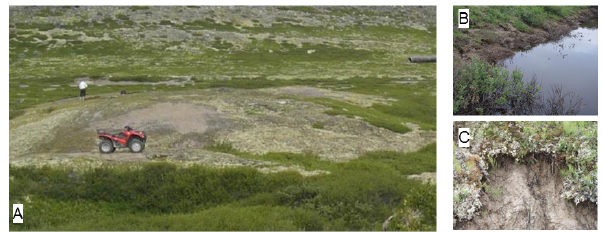
Figure 1. (a) A typical lithalsa within the study area near Umi- ujaq (northern Quebec) with a diameter of 20m. Photo taken in April 2009, to the east of the cuestas (56 ◦ 33 (cid:48) N, 76 ◦ 28 (cid:48) W). (b) Thermokarst pond and eroding slope on Lithalsa R. (c) Cracks up to 0.5m deep on slope of Lithalsa